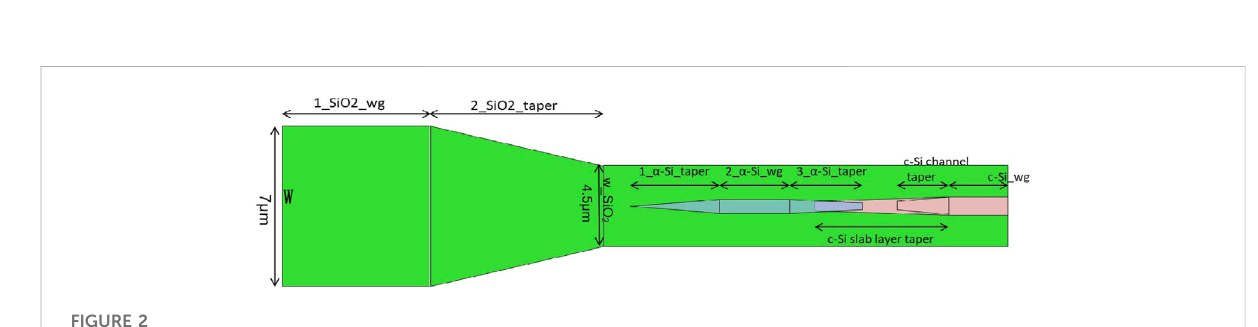
FIGURE 2 Top view of the double-layered edge coupler.